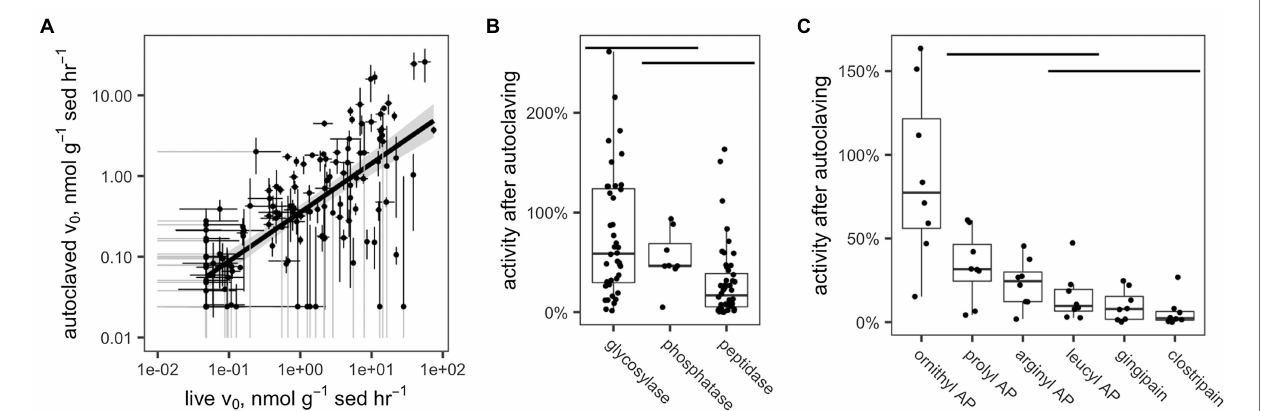
FIGURE 5 | (A) Measured hydrolysis rates of live vs. autoclaved sediments. In order to increase legibility on the log-log plot, v 0 values have been adjusted to the detection limit of 4.77 × 10 − 2 n mol g sed − 1 h − 1 (live sediments) or 2.41 × 10 − 2 n mol g sed − 1 h − 1 (killed sediments). Standard error bars that dip below 1 × 10 − 2 μ molg sed − 1 h − 1 are truncated and colored gray. (B,C) Fraction of enzyme activity remaining after autoclaving by (B) enzyme class and (C) enzyme, within the peptidase class. Horizontal bars indicate distributions that are statistically indistinguishable ( α = 0.05, Conover-Iman